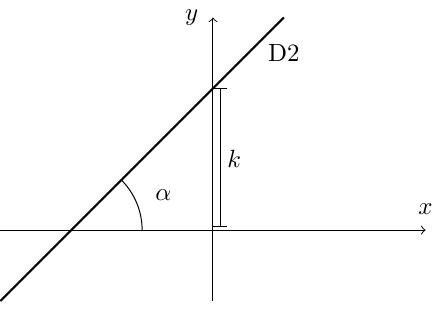
Figure 2 . A projection of eq. (5.3) onto the equation y = x tan (cid:11) + k , where the angle (cid:11) would be derived from the constant C , and k from (cid:20)